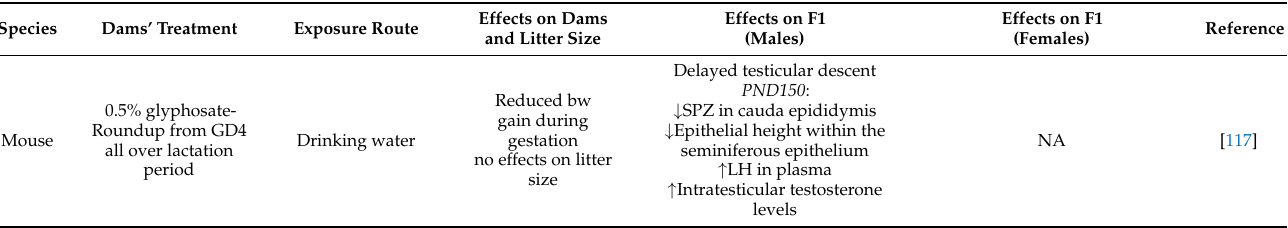
Table 2. Exposure to glyphosate and glyphosate-based herbicides (GBHs) during pregnancy and lactation: effects on the development, reproduction and fertility of the